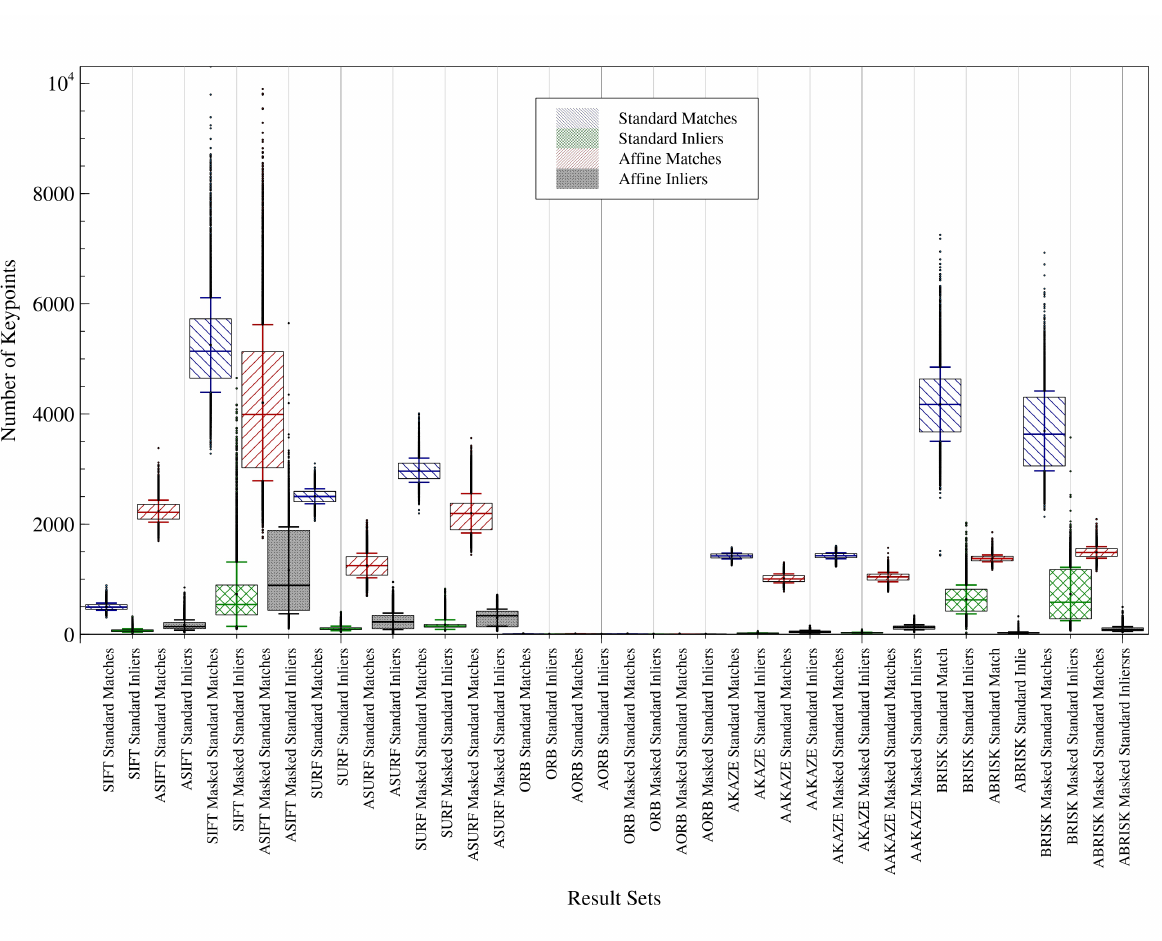
Figure 12. The average, standard deviation, and outliers of the number of keypoint matches and inliers computed across the entire sample, arranged by method and